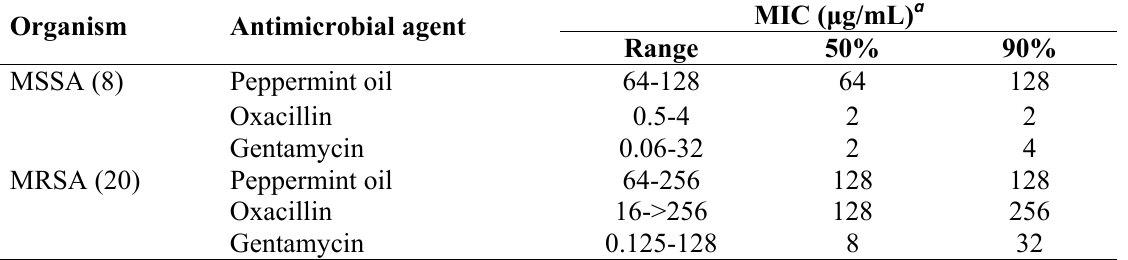
Table 2. MICs of peppermint oil, oxacillin, and gentamicin against 28 clinical isolates of S. aureus.